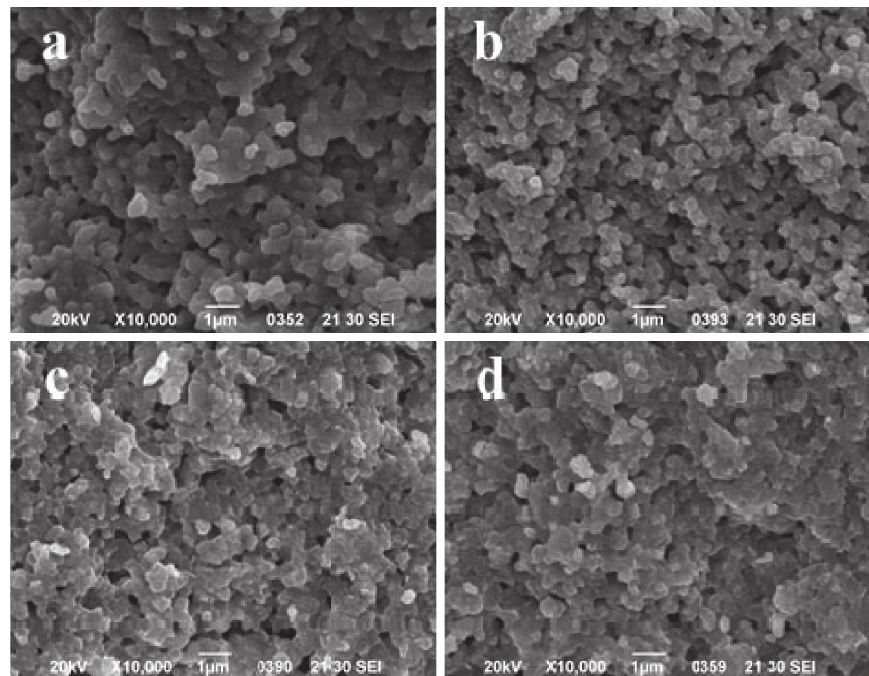
Figure 7: SEM images of four ceramic rings of group A obtained at different microwave sintering temperatures. (a) 1350 ° C, (b) 1400 ° C, (c) 1450 ° C, and (d) 1500 °